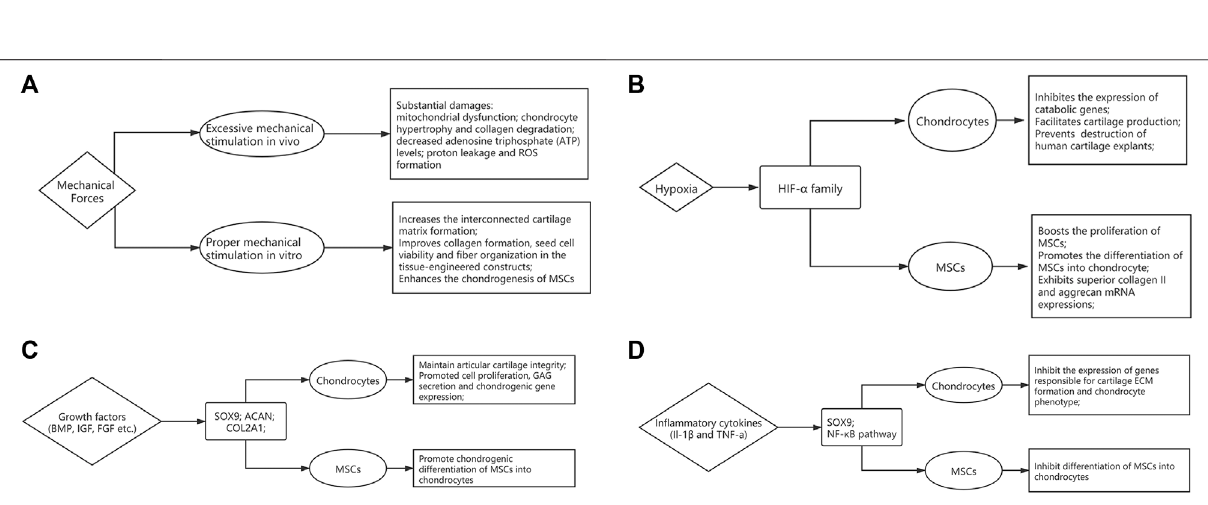
Frontiers in Bioengineering and Biotechnology |